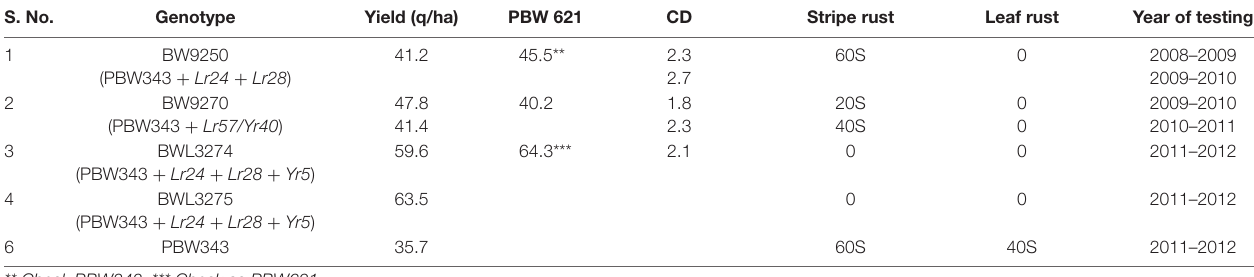
77-5 and 104-2) and (Stripe rust: mixture of races 78S84 and 46S119) reaction at two locations in